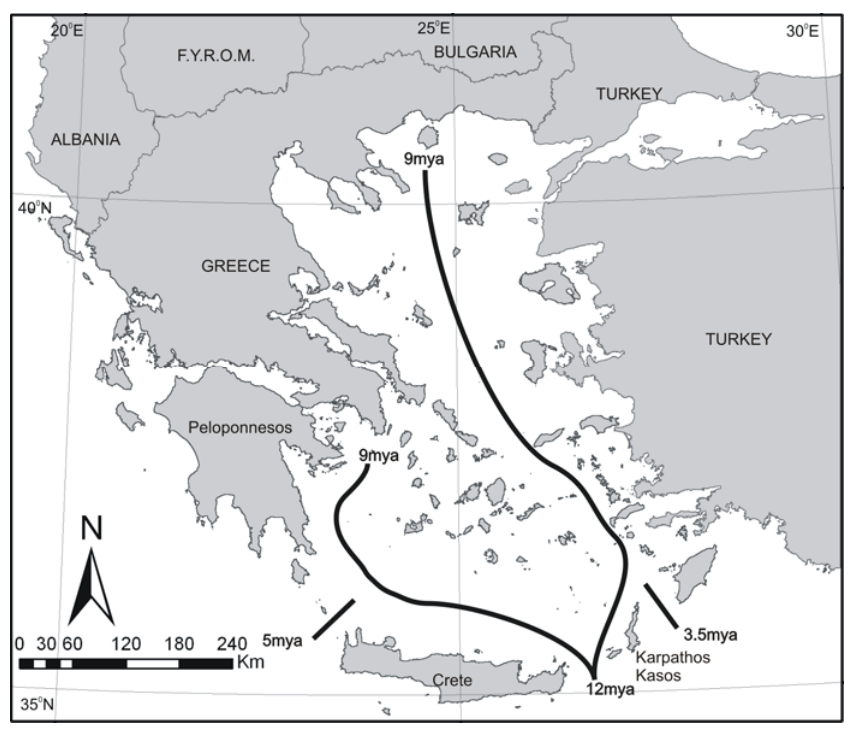
Figure 3. Basic barriers of geological origin in the Aegean. The exact depiction of the Mid-Aegean Trench’s position (especially in its southern third) reflects the authors’ synthesis of extant biological and geological